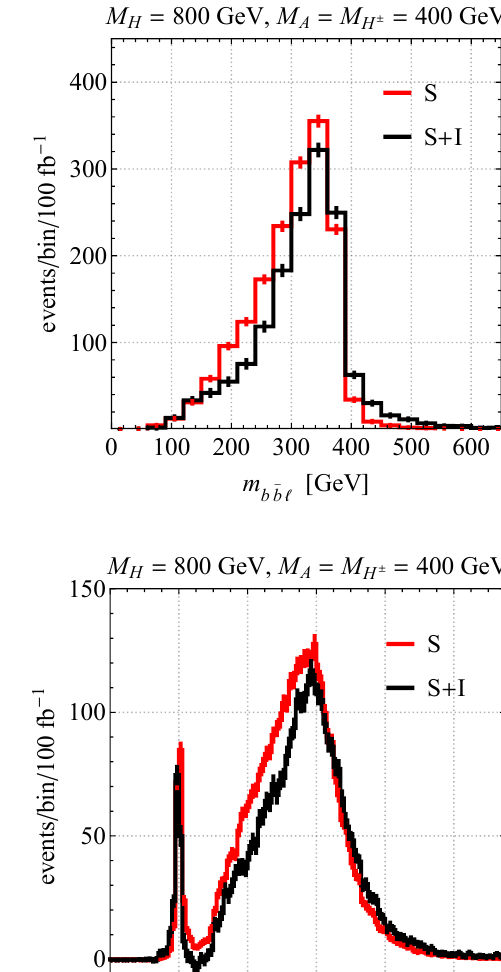
Figure 6 . Invariant mass distributions of the tbW signal: m right panel), m tb (lower left panel) and m tbW (lower right panel),. The displayed predictions have been obtained in the type-II 2HDM using M H = 800 GeV, M A = M and t (cid:12) = 1. The red and black curves correspond to the results at and including (S+I) the interference with the SM background. The error bars represent statistical